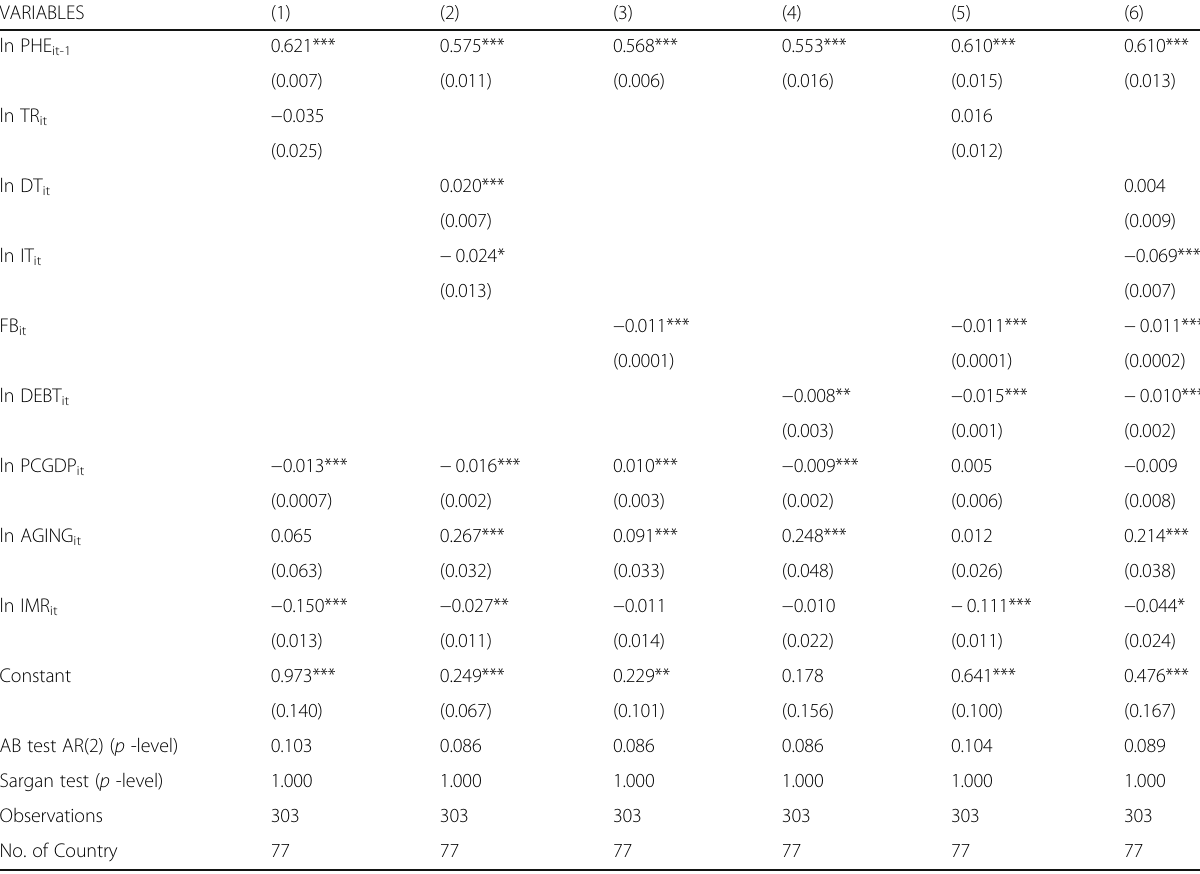
Table 3 Dynamic System GMM Regression Model (Post-Global Financial Crisis)